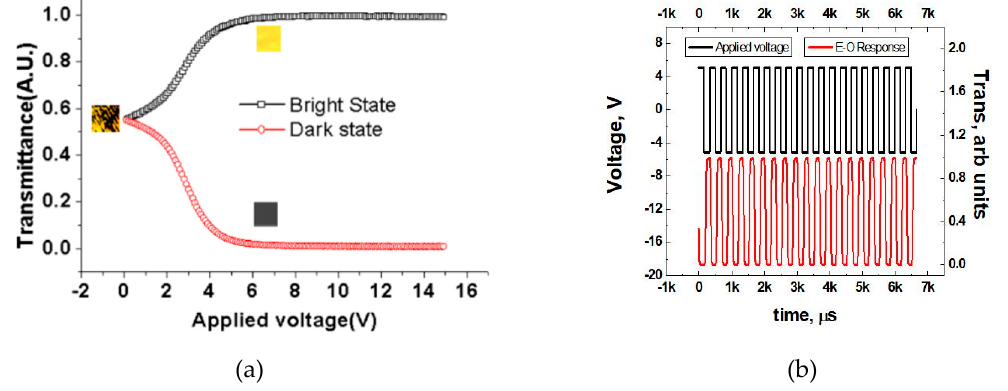
Figure 14. ( a ) Transmittance vs. voltage for bright and dark states of the ESHFLC mode. ( b ) Electro-optic performance of ESHFLC mode in comparison with the applied voltage (3 kHz, 5 V).